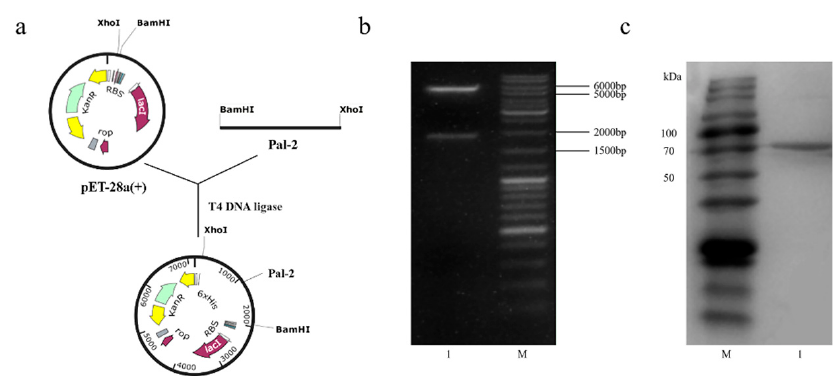
Figure 2. Construction and expression of the recombinant Pal-2 ( a ) Construction process of plas- mid pET-28a(+)- pal 2. ( b ) Enzymatic digestion analysis of pET-28a(+)- pal 2. ( c ) SDS-PAGE verification of the recombinant Pal-2. Lane M: protein size marker, Lane 1: Pal-2.